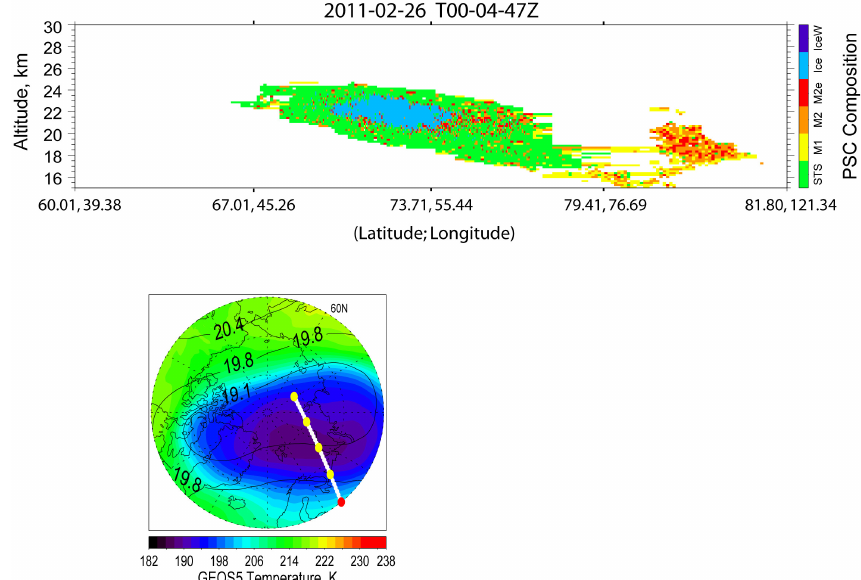
Figure 2. CALIPSO PSC composition for the PSC measured along the orbit track starting at 25 February 2011, 23:56UTC. Shown is the composition for the measurement on 26 February 2011 at 00:04UTC and the GEOS-5 temperatures and geopotential height fields (in gpkm) at 30hPa at 12:00UTC (bottom). The white line marks the CALIPSO orbit